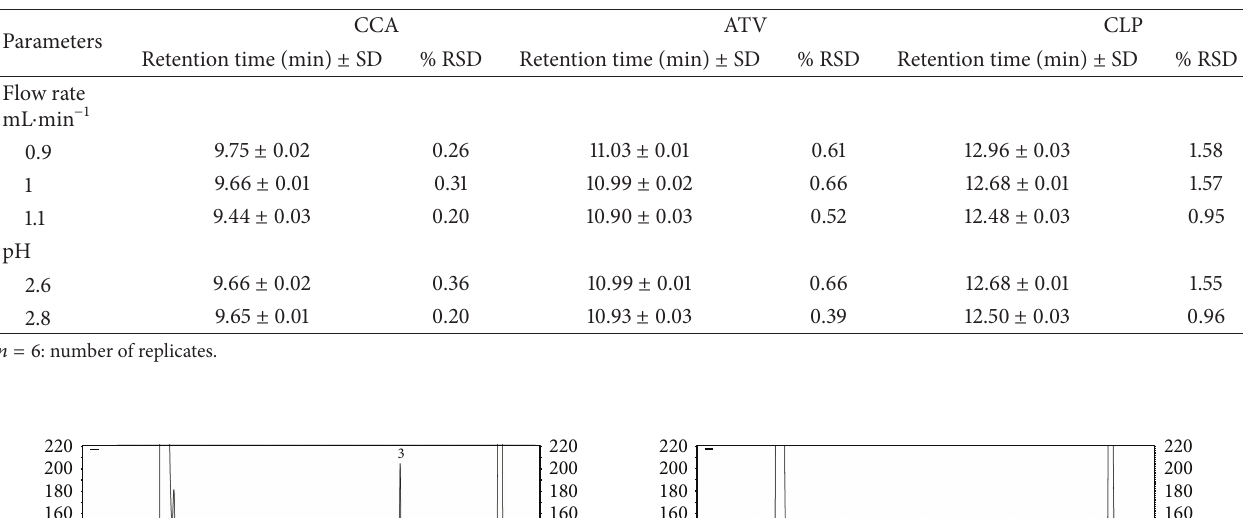
Table 4: Robustness results for the RP-HPLC method.